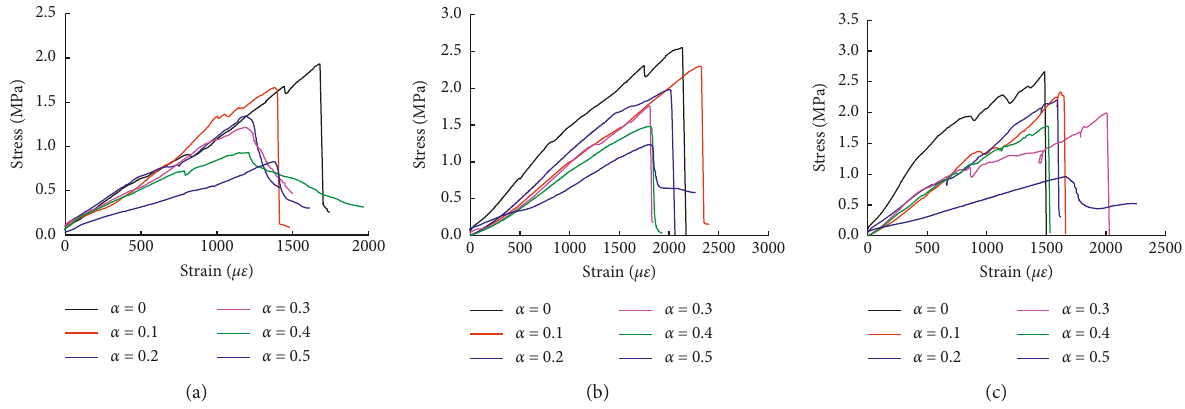
Figure 6: Biaxial compression-tension stress-strain curves of plain concrete. Ordinary concrete: (a) C30; (b) C40; (c)